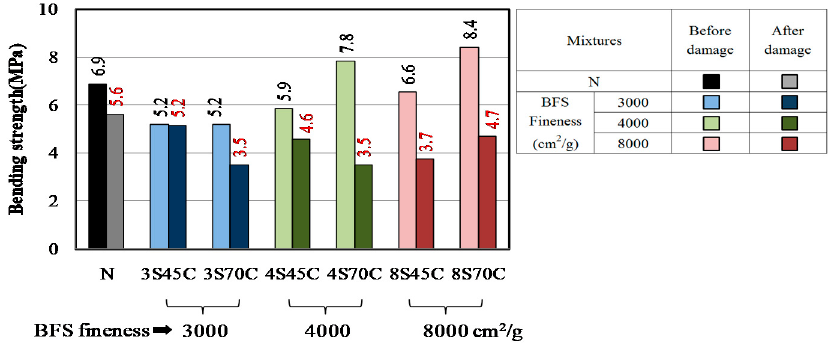
Figure 8. Changes of bending strength in different mortar samples.